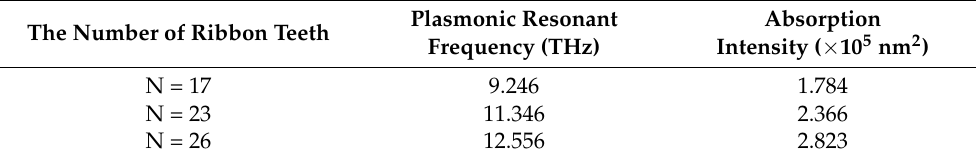
Table 5. Variations of absorption characteristics under change of teeth number of combline structure.